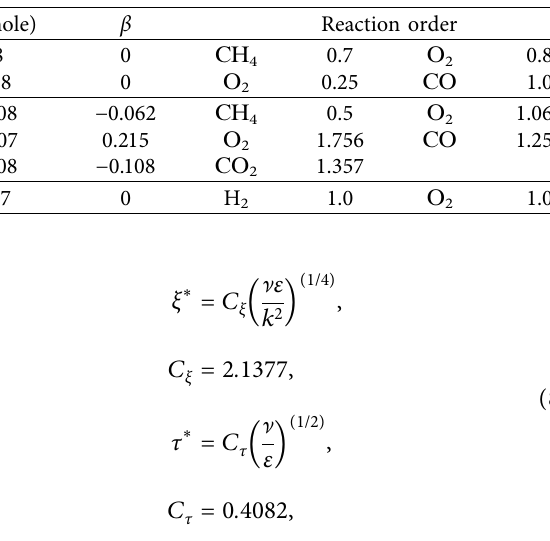
Table 1: Mechanism of fuel oxidation.